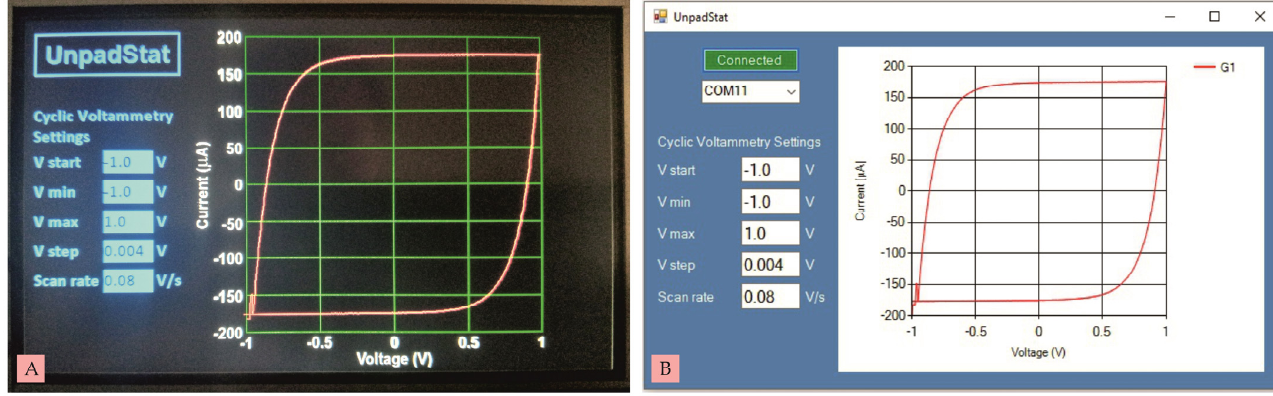
Figure 7. ( A ) CV measurement on a dummy circuit using Nextion, ( B ) CV measurement on a dummy circuit using a computer.